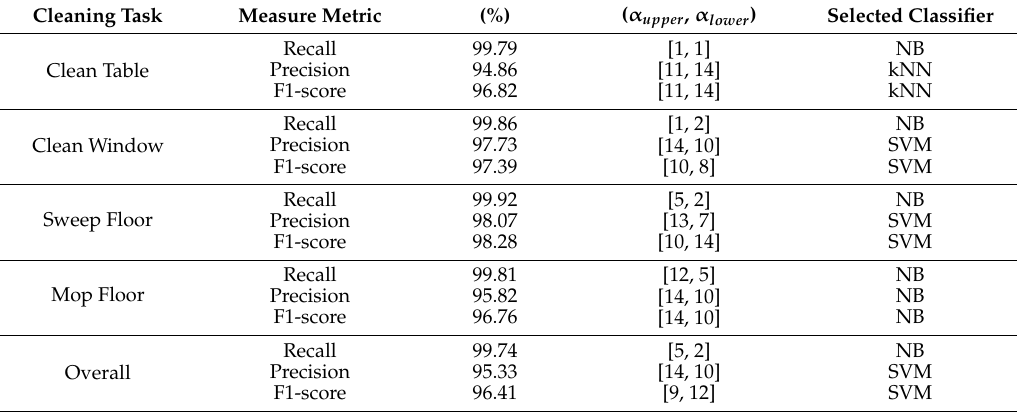
Cleaning Task Measure Metric (%) ( α upper , α lower ) Selected Classifier